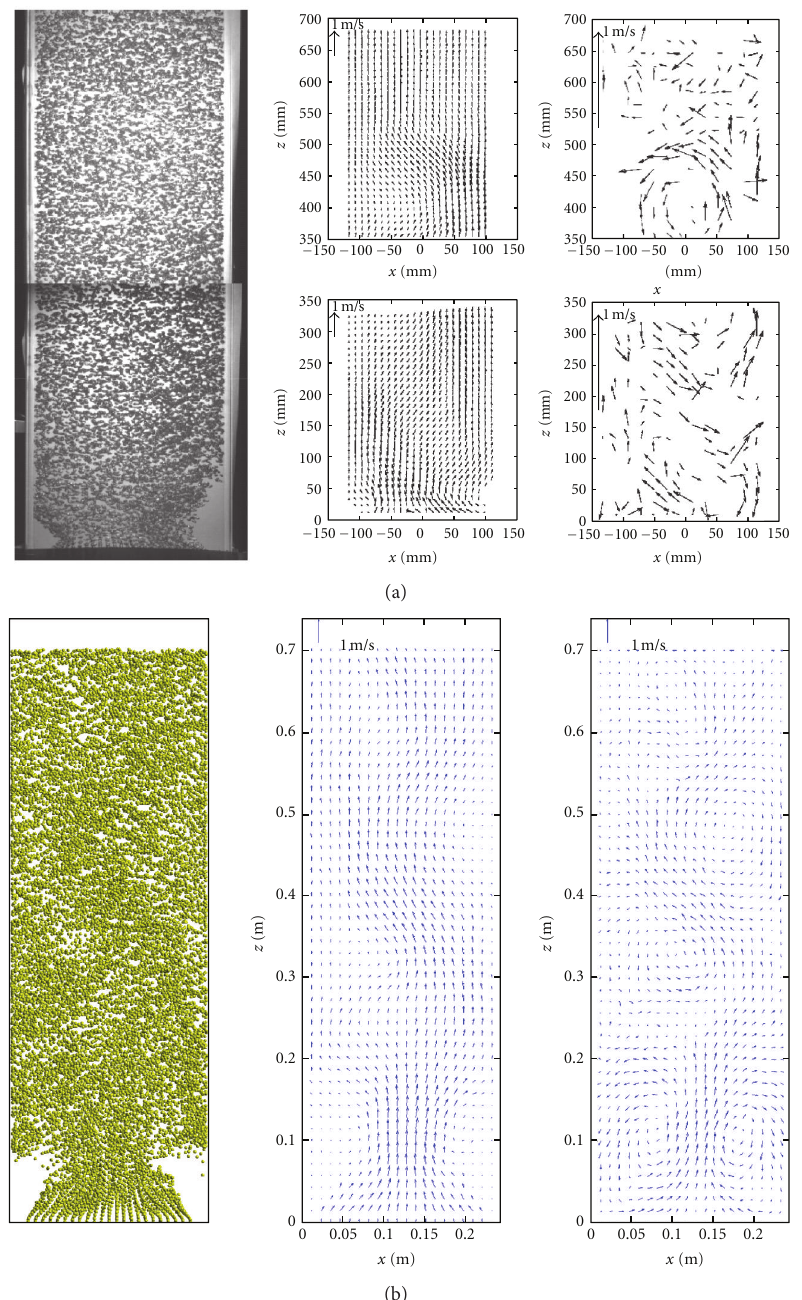
Figure 12: Instantaneous flow structure comparison between experiment (a) and simulation (b). From left to right: bubble positions, bubble velocity, and liquid velocity (from Darmana et al.